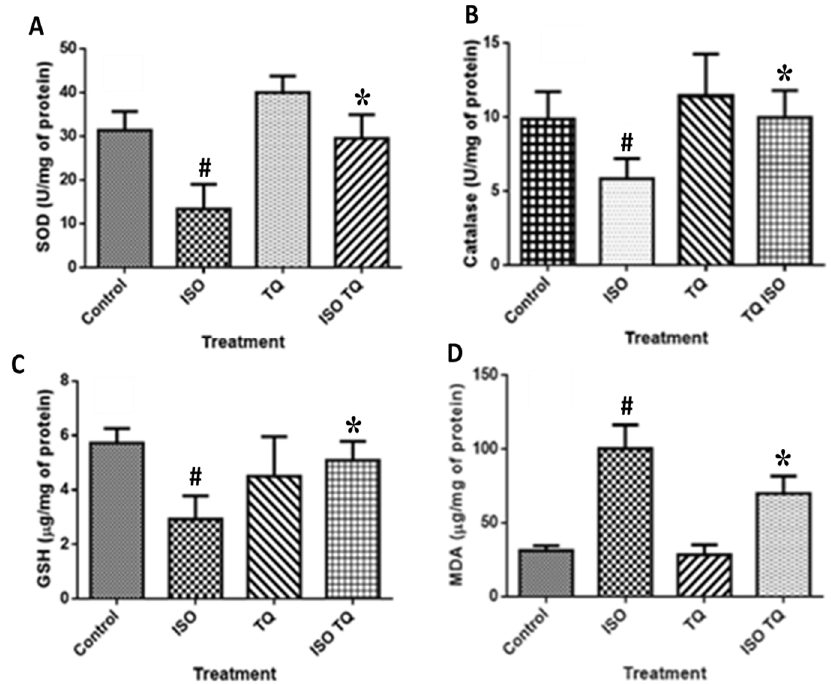
Figure 4. Effect of TQ on oxidative stress parameters ( A ) SOD, ( B ) CAT, ( C ) GSH, and ( D ) MDA in ISO-induced myocardial infarction in rats. Data were analyzed by one-way analysis of variance (ANOVA) followed by Dunnett’s post-hoc test. * p < 0.001 vs. normal control; # p < 0.001 vs. ISO. Data are expressed as mean ± SEM (n = 6). CAT: Catalase; GSH: glutathione; ISO: isoproterenol; MDA: malondialdehyde; SOD: superoxide dismutase; TQ: thymoquinone.